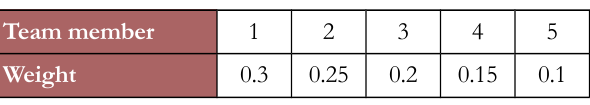
Table 3. Weight assignment of each team